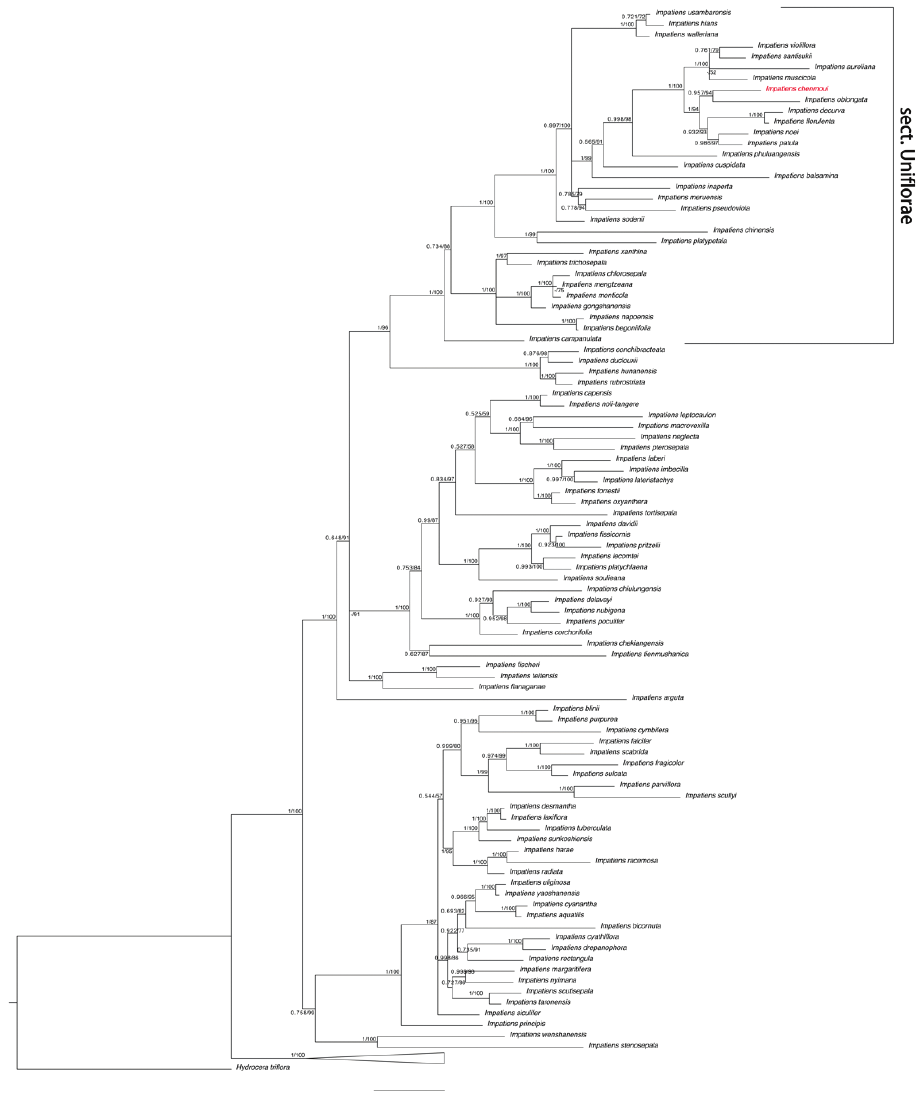
Figure 1. Phylogenetic tree based on combined datasets of the nuclear ITS and plastid atpB–rbcL DNA sequences. The topological structure comes from Bayesian inference. Numbers near nodes are PP/BS, a dash ‘–’ indicates nodes not supported, subgen. Clavicarpa was